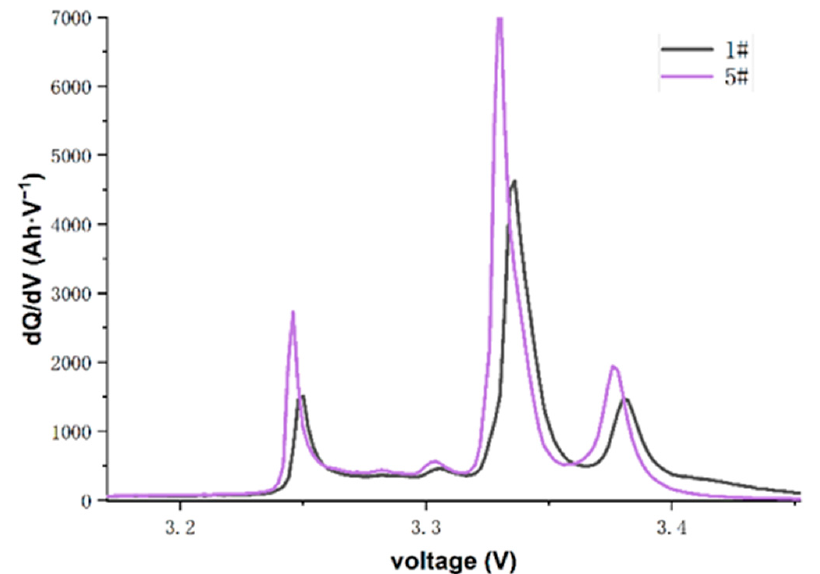
Figure 15. The IC difference between 1# and 5#.